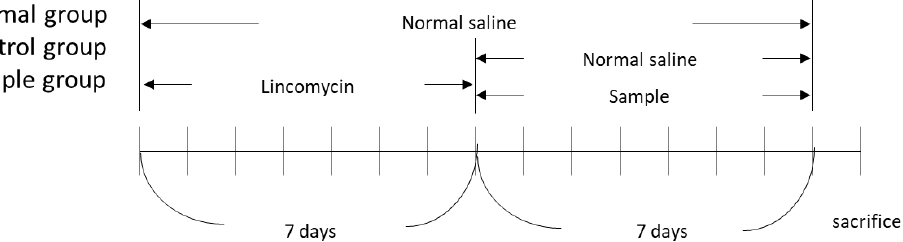
Figure 1. Schedule of the in vivo experiment to induce an antibiotic-associated diarrhea model in BALB/c mice.